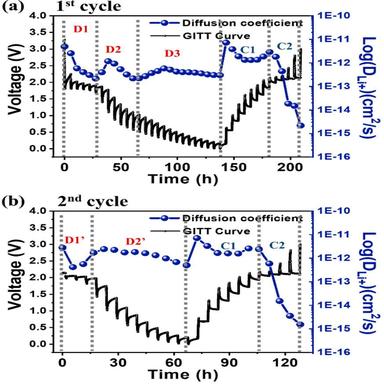
GITT curves of V2Se9 during the (a) first and (b) second cycles.